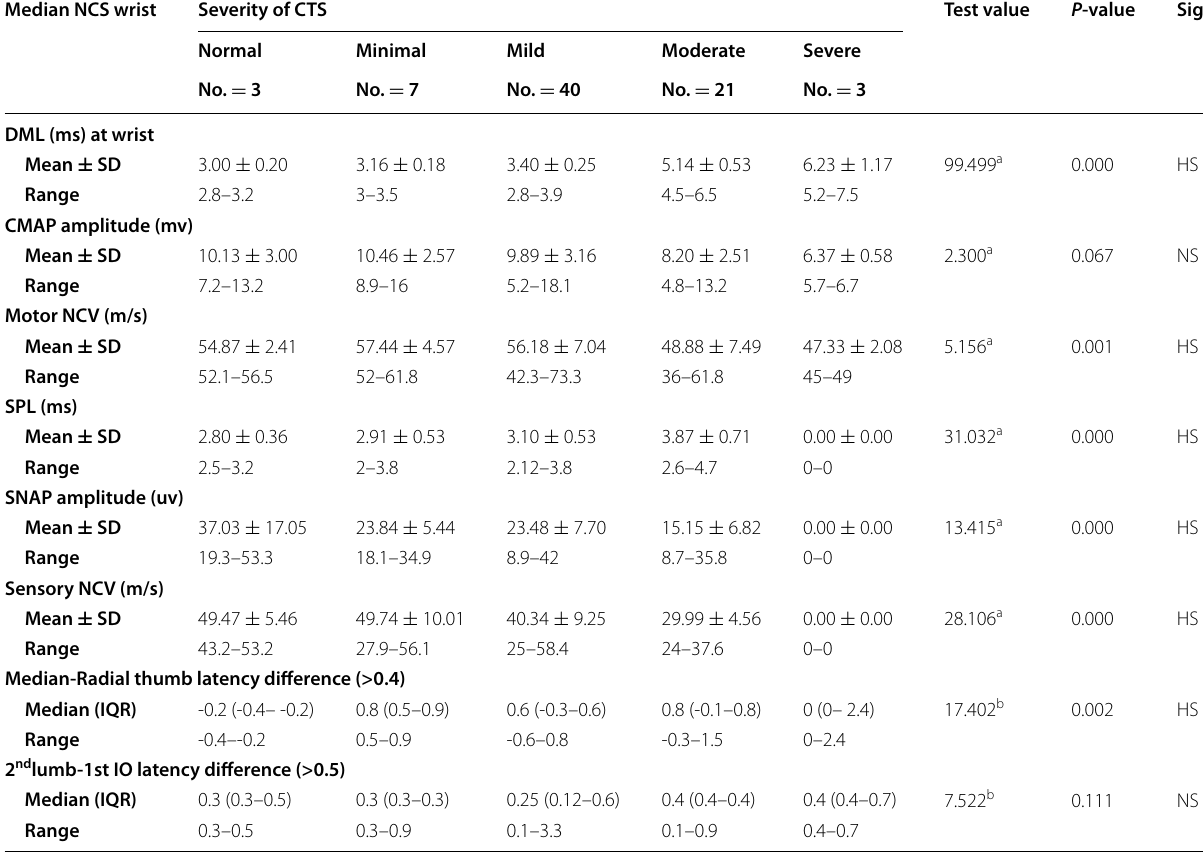
Table 3 Relation between carpal tunnel syndrome severity and electrodiagnostic findings